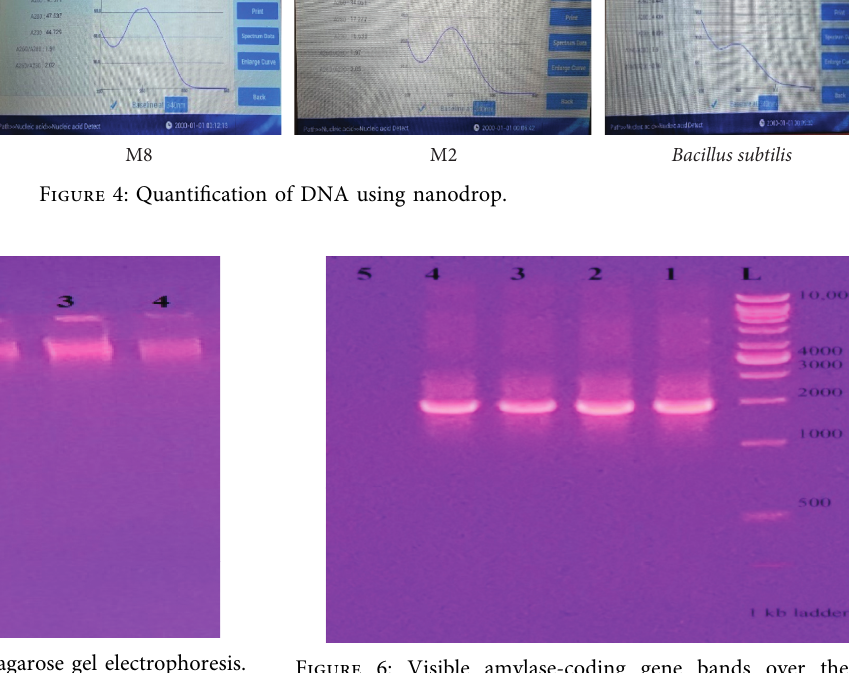
6: Visible amylase-coding gene bands over the UV transilluminator on 1% agarose gel